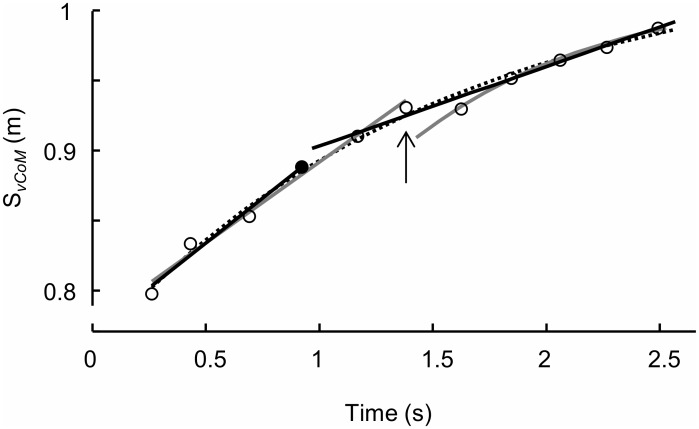
Example of CoM’s vertical position and curve fitting from step to step in time.Open markers are data, solid marker indicates the breakpoint according to Nagahara et al. [10] and piecewise twice linear fit (solid lines, Eq 5a). Vertical arrow indicates the breakpoint according to linear-exponential piecewise fit (grey curves, Eq 5b). Dotted line is exponential fit (Eq 4).